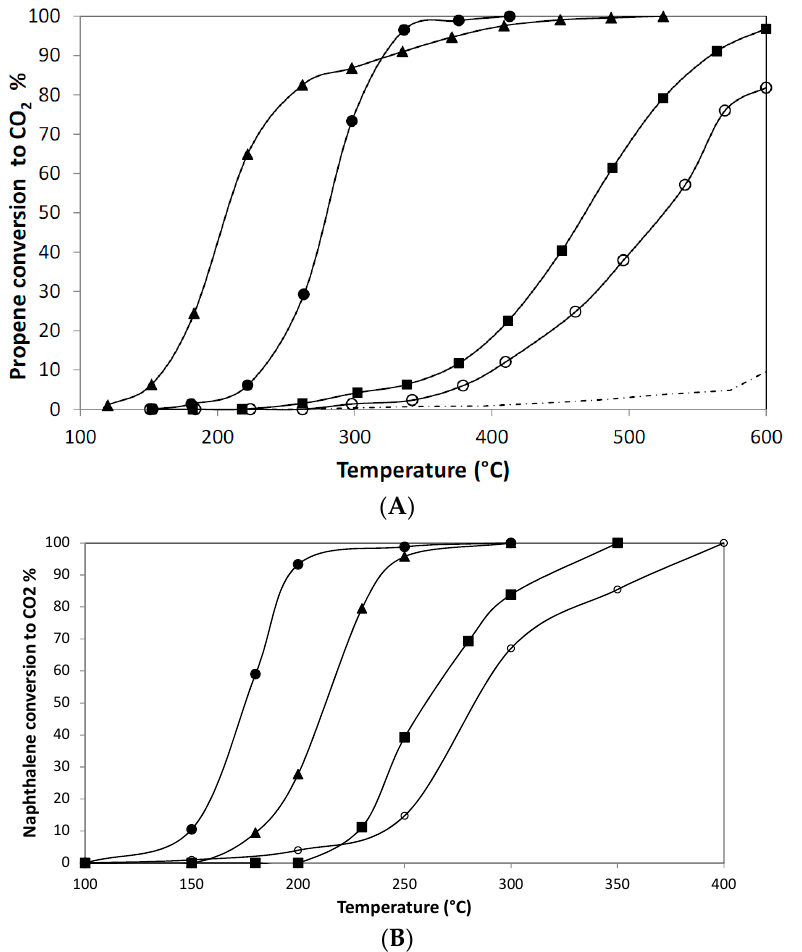
Figure 8. ( A ) Catalytic activity in propene oxidation: (----) without catalysts, (o) ZrO 2 , ( ■ ) Ag1Z, ( ● ) Ag5Z, ( ▲ ) Ag10Z. ( B ) Catalytic activity in naphthalene oxidation: (o) ZrO 2 , ( ■ ) Ag1Z, ( ● ) Ag5Z, ( ▲ ) Ag10Z.